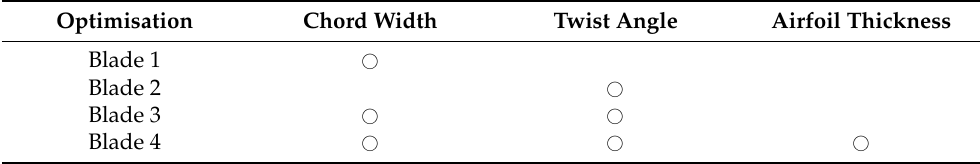
Table 3. Variables considered in the four optimisation studies.